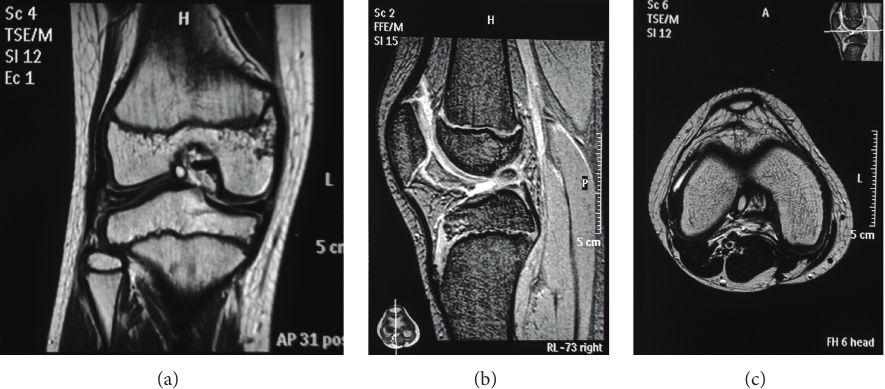
Figure 2: MRI: (a) coronal section, (b) sagittal section, and (c) axial section showing the ossicle within the substance of the anterior cruciate